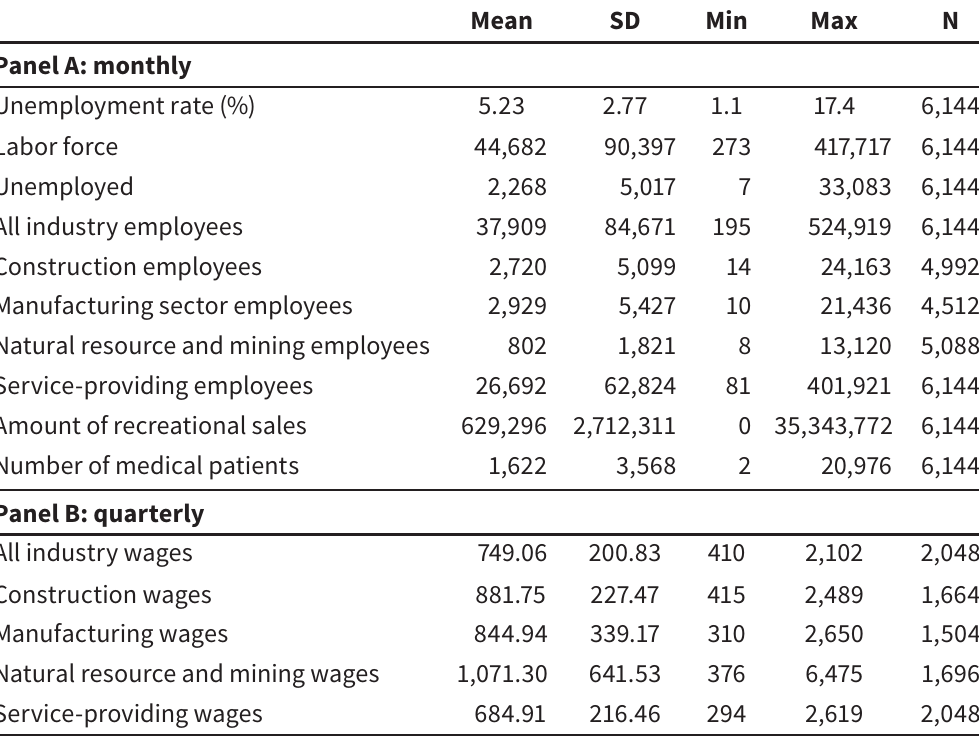
County-level summary